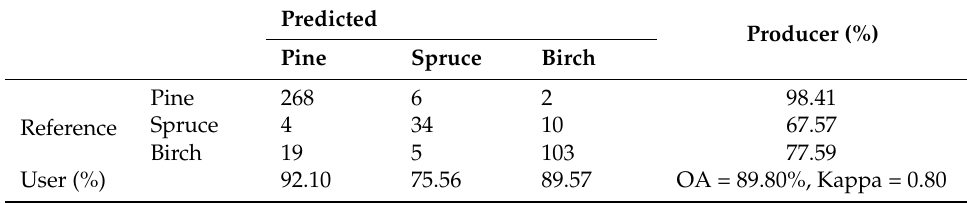
Table 11. Confusion matrix of classification with point cloud and intensity features for group of trees (C2).